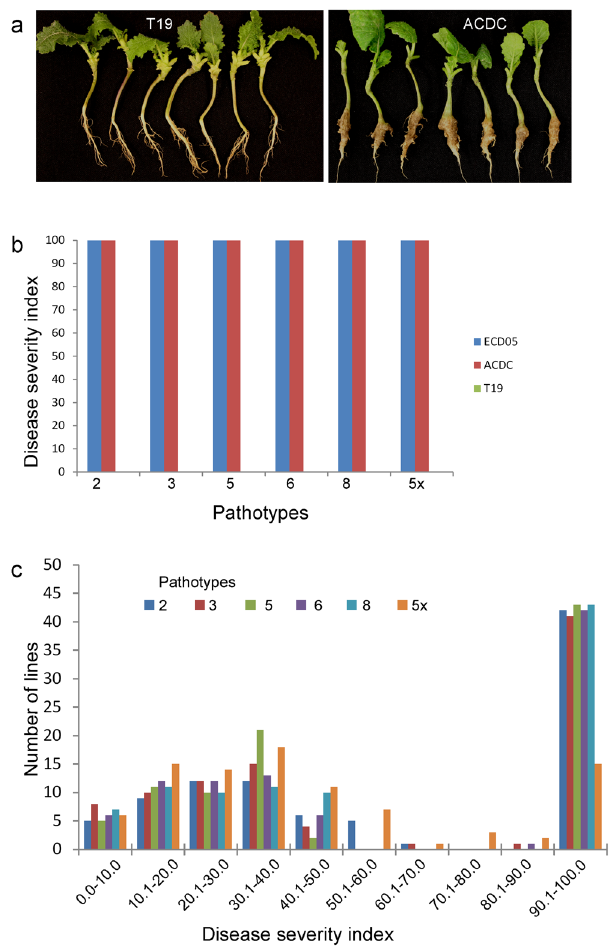
Figure 1. Evaluation of parental lines and BC 1 S 1 population derived from ACDC × (ACDC × T19) for resistance to clubroot. ( a ) R and S phenotypes in the parental lines with pathotype 3; ( b ) Disease severity indexes (DSIs) of the parental line and susceptible control ECD 05 with pathotype 2, 3, 5, 6, 8 and P5x of Plasmodiophora brassicae ; ( c ) Distribution of DSIs in the BC 1 S 1 population consisting of 92